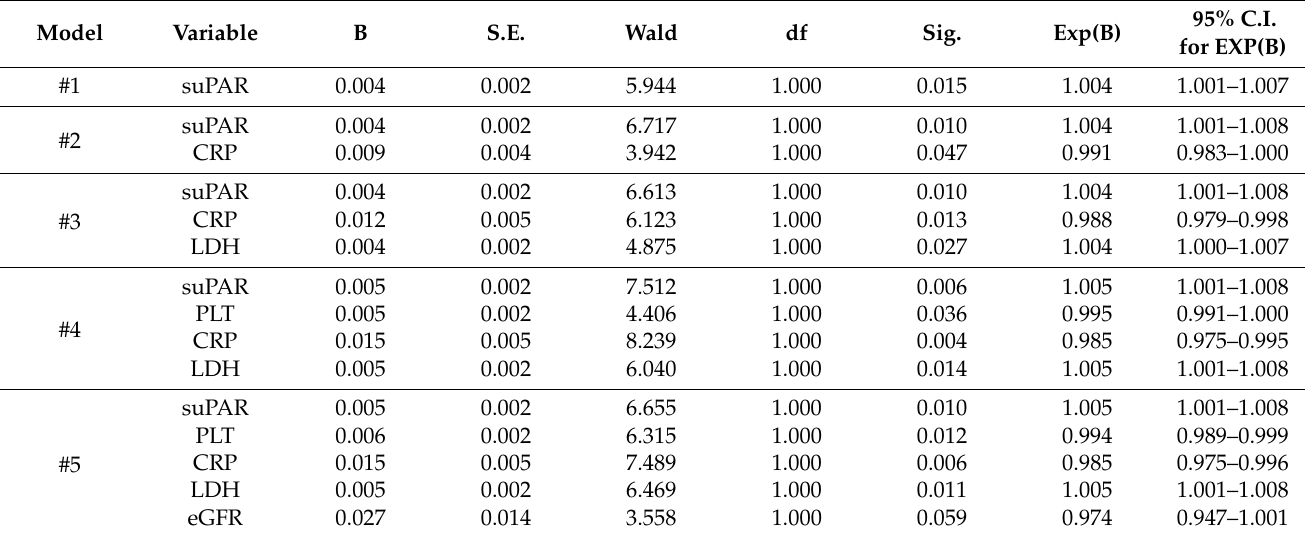
Table 3. Binary logistic regression analysis for acute kidney injury (AKI) (dependent variable) and di ff erent laboratory markers (explanatory variables).